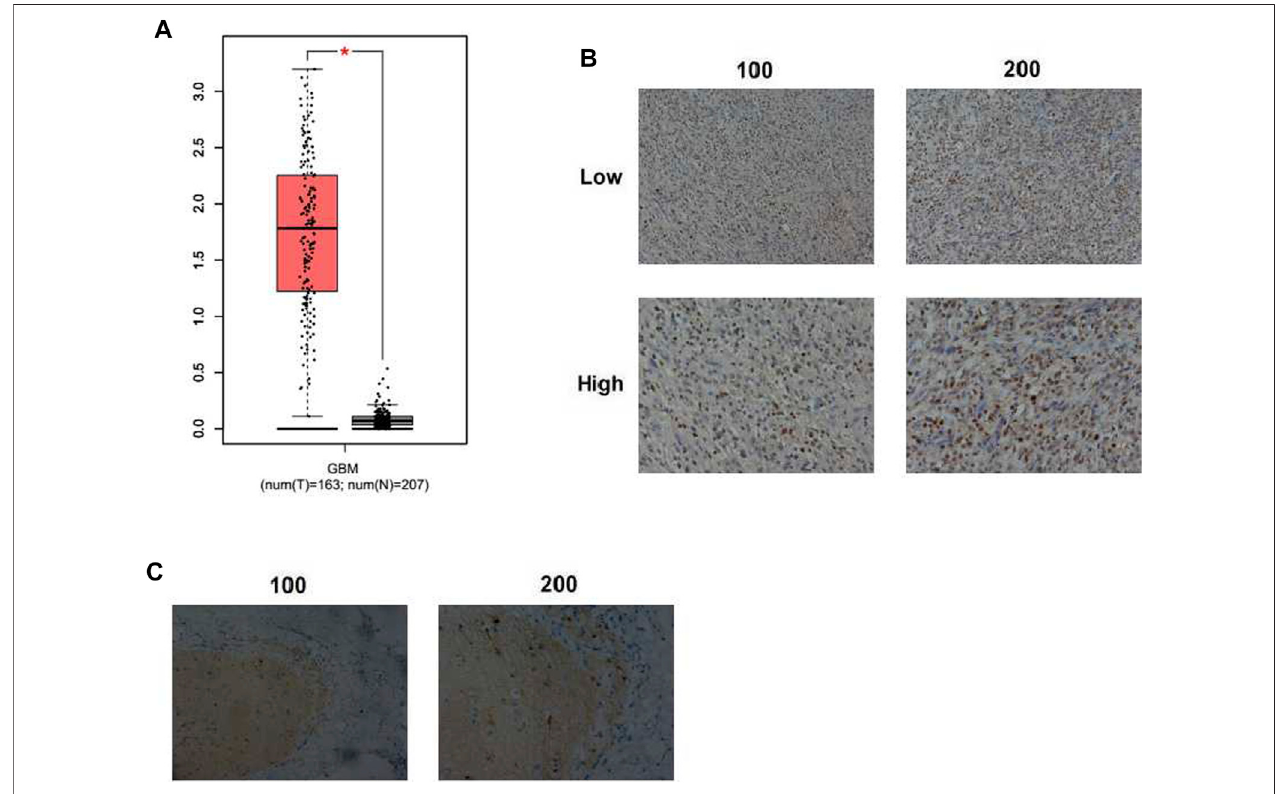
FIGURE 3 | KIF18A expression in human GBM tissues. (A) Expression levels of KIF18A in human GBM and normal tissues (GBM: glioblastoma, * p < 0.05). (B) Immunohistochemical (IHC) staining of KIF18A protein in human GBM tissues (×100 and ×200 magni fi cation, resp.). (C) IHC staining of KIF18A in the adjacent tissues (×100 and ×200 magni fi cation,